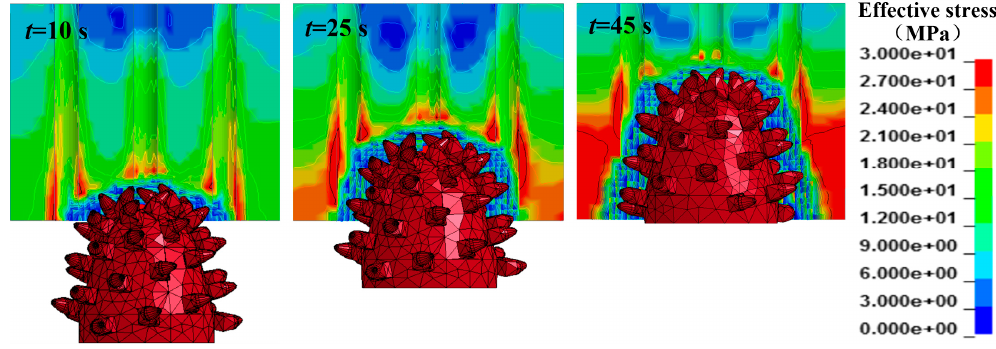
Figure 23. Fragmentation process of rock with five holes under the confining pressure of 10 MPa.